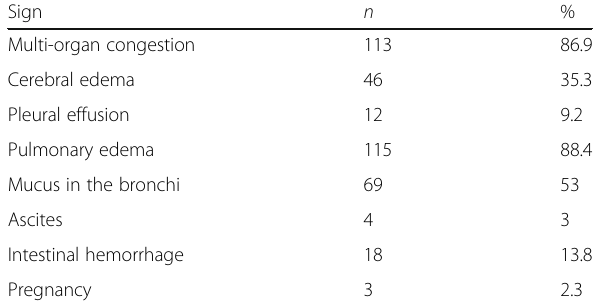
Table 3 Signs during